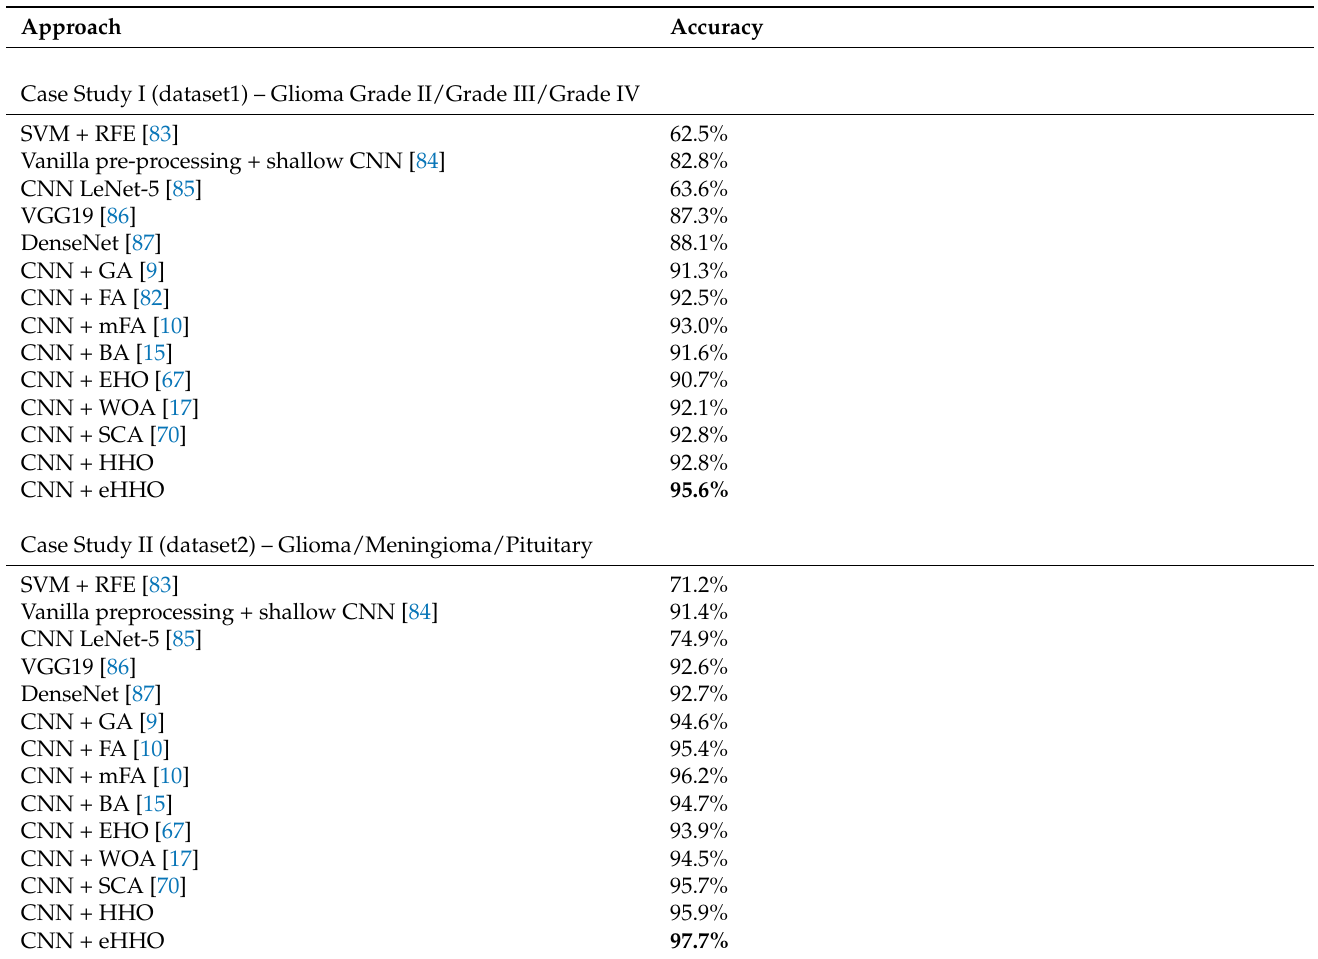
Table 9. MRI tumor grades classification comparative